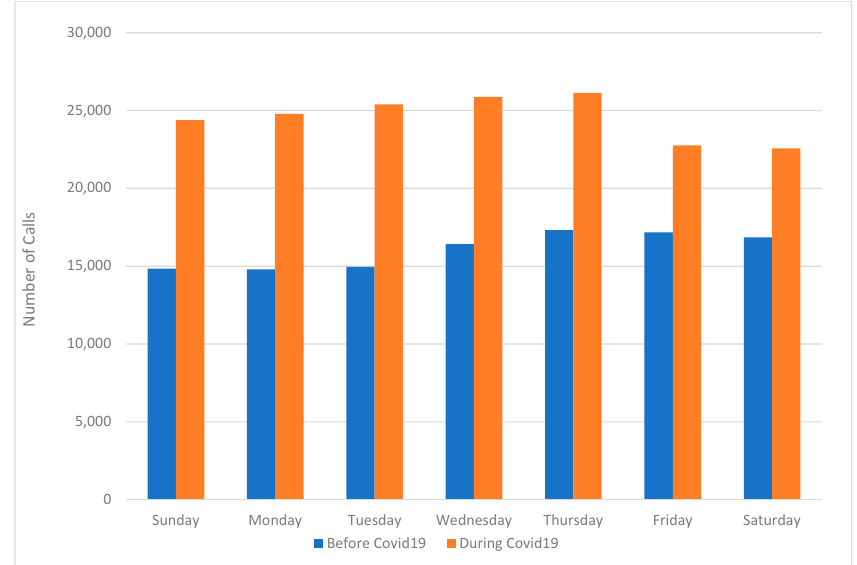
Figure 4. Comparison of the number of EMS calls per day of the week before and during COVID-19. Before